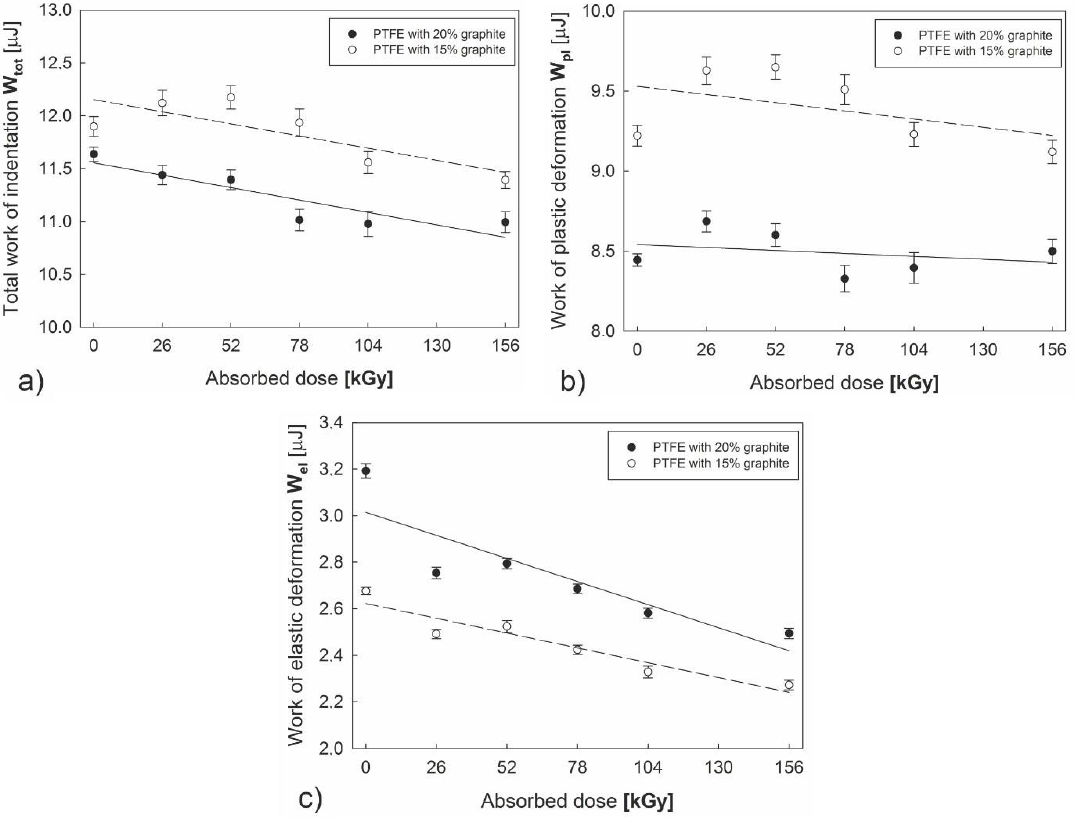
Figure 7. Changes in the work of indentation of PTFE with different graphite additions subjected to absorbed dose of electron beam irradiation: the total work of indentation—W tot ( a ), the work of plastic an absorbed dose of electron beam irradiation: the total work of indentation — W tot ( a ), the work of deformation—W pl ( b ), and the work of elastic recovery W el ( c plastic deformation — W pl ( b ), and the work of elastic recovery W el ( c ).